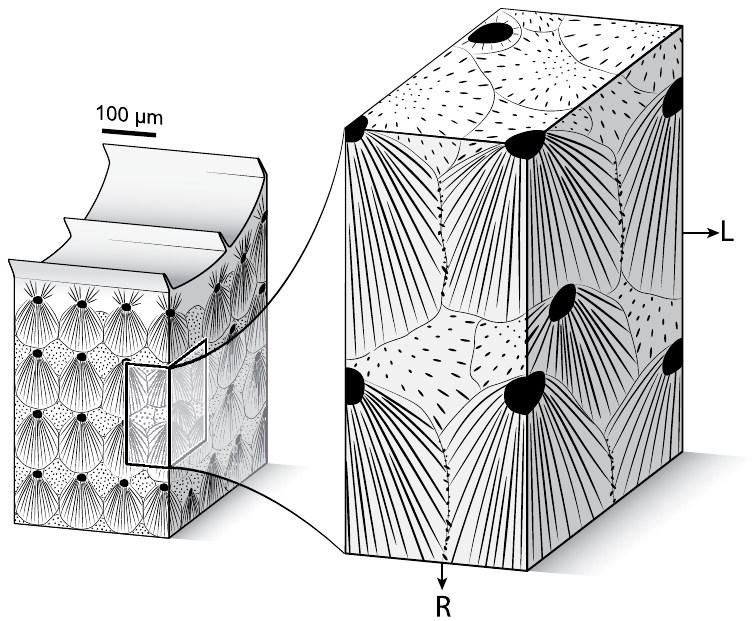
Figure 7. Three-dimensional model of the sclerodermite organization. Black dots and lines represent RADs and needles, respectively. On the right panel, the left part of the front surface corresponds to a yellow colour-coded transcurrent layer (as defined in Fig. 4) while the right part corresponds to a red colour-coded transcurrent layer. Because sclerodermites form three-dimensional bundles expanding towards all free directions, needles growing from RADs lying slightly off-axis with respect to the radial growth direction intersect the acquisition surface at high angles and form the multi-coloured patches visible in Fig. 2. They do not, however, interrupt the continuity of transcurrent layers. R and L as in Fig. 2. Artwork by A. Lethiers, used with